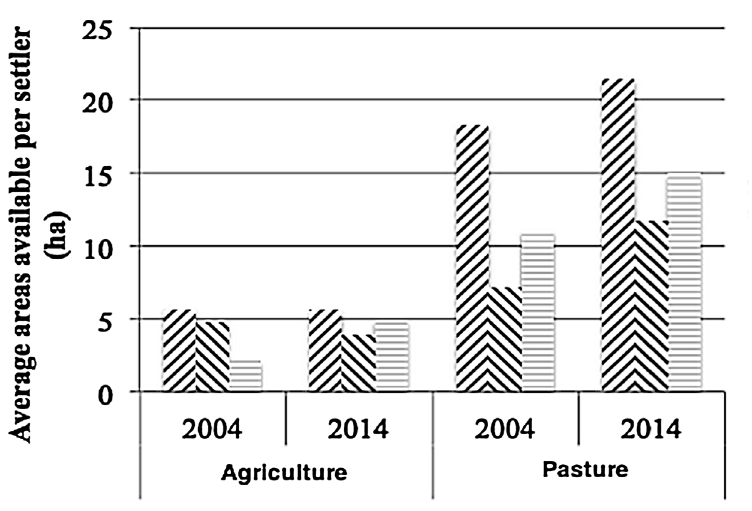
Figure 4. Average areas in hectares of agriculture and pasture available to settlers in 2004 and 2014 by